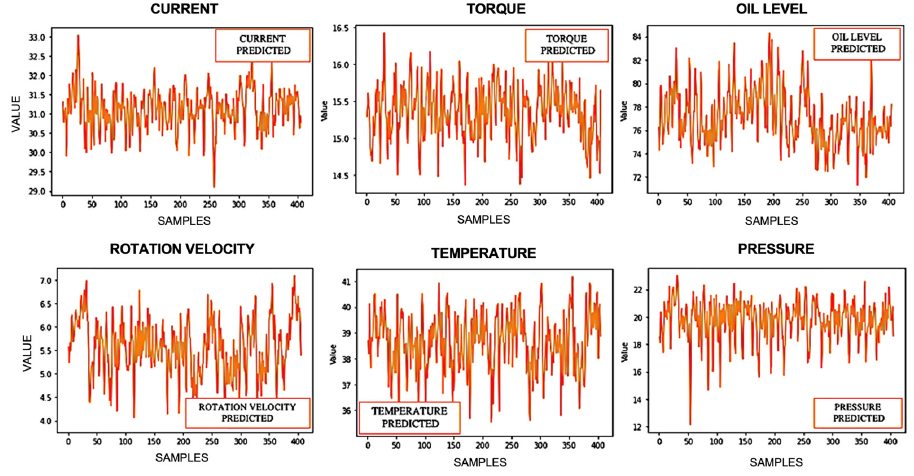
Figure 4. Predicted time series of sensor values.